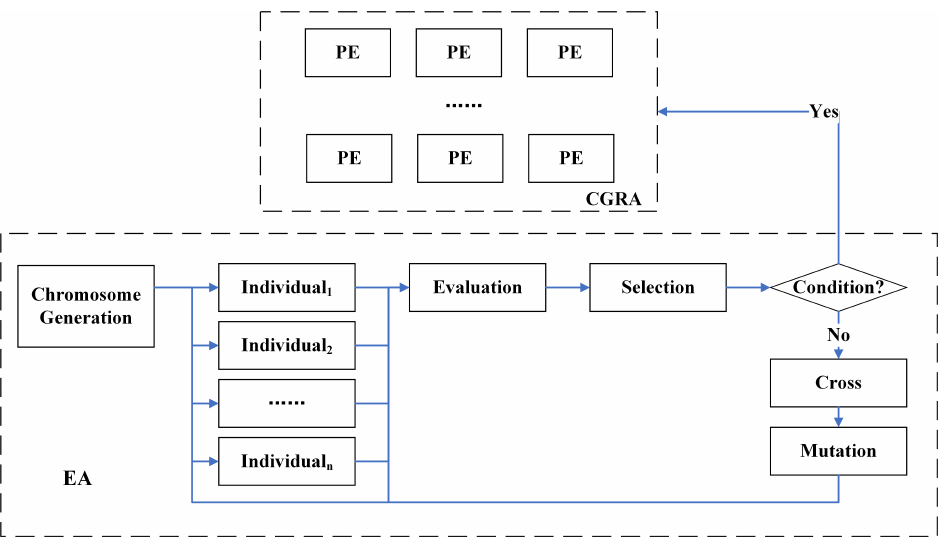
Figure 5. The implementation procedure of evolutionary